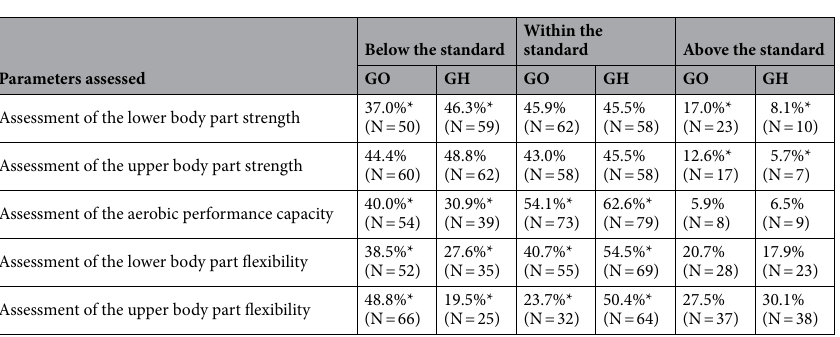
Table 6. Assessment of SFT physical fitness level. (GO – the group of women with osteoporosis, GH – the group of healthy women; * p < 0.05).